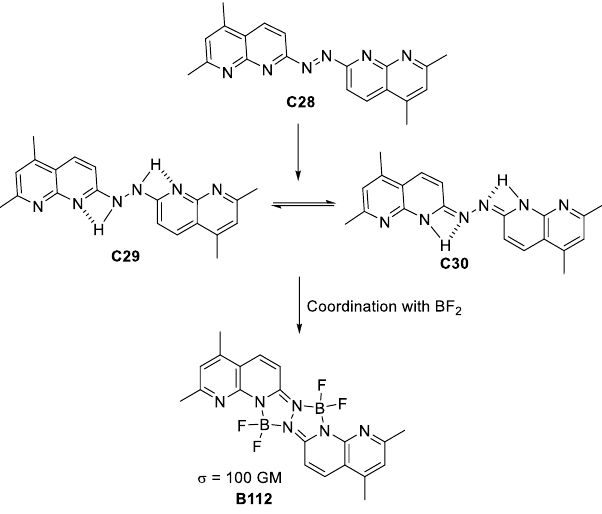
Figure 35. BF 2 -based, hydrazine-coordinated species of quadrupolar architecture presenting